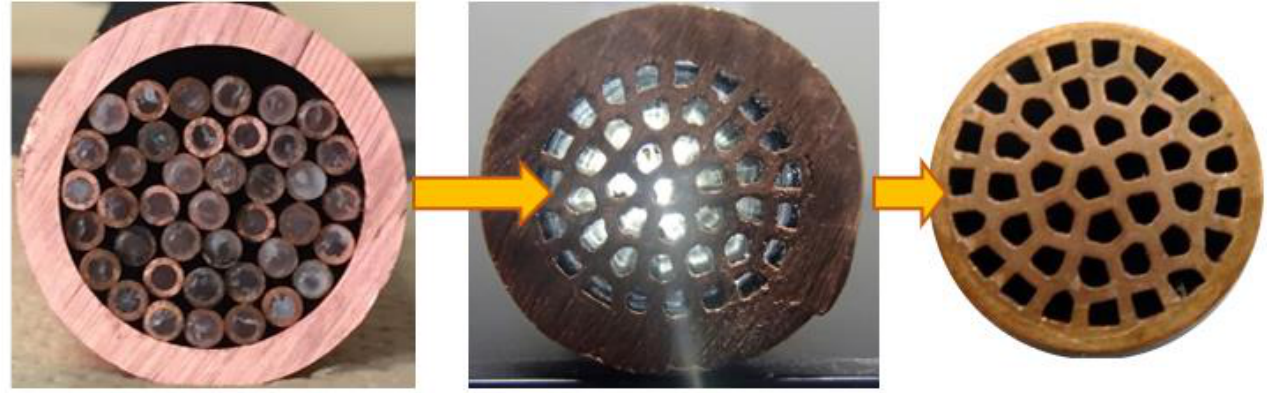
Figure 3. Unidirectional porous copper tube #1 (before and after explosive compaction).